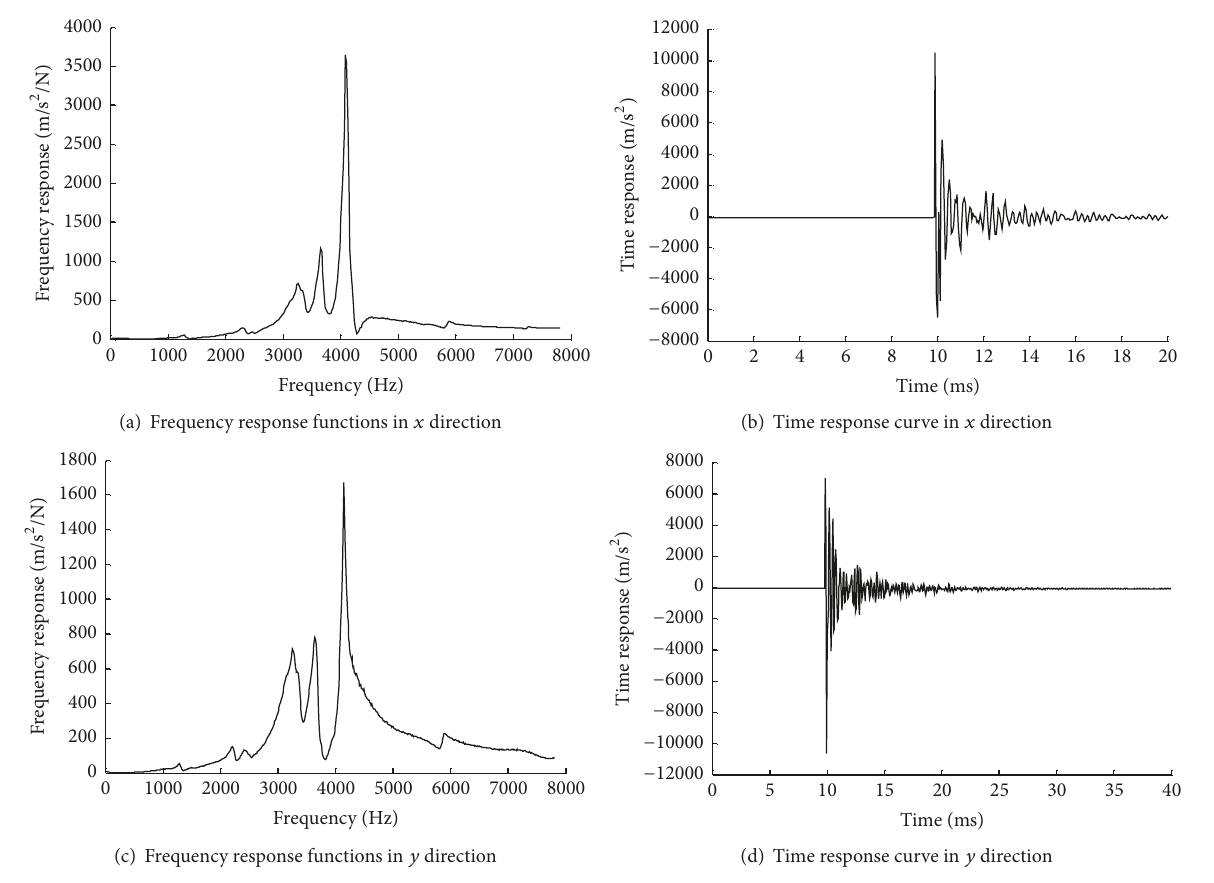
Figure 5: Results of modal experiments with hammering